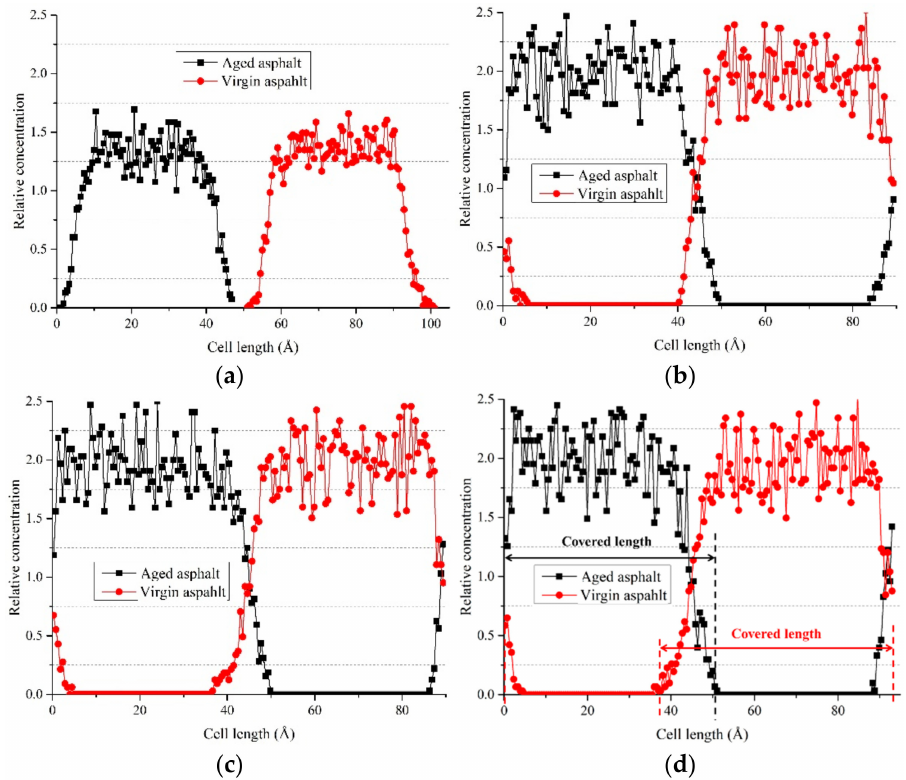
Figure 7. Relative concentration at different temperatures: ( a ) initial state; ( b ) 383.15 K; ( c ) 413.15 K; ( d ) 443.15